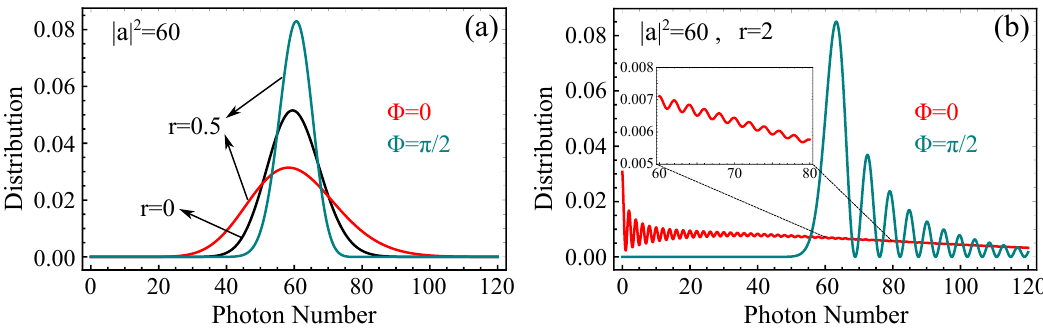
Figure 2. ( a ) Photon number distribution of a squeezed coherent state with | a | 2 = 60 and r = 0.5, compared with the respective distribution of a coherent state ( r = 0, black line). ( b ) Photon number distribution of a squeezed coherent state with | a | 2 = 60 and r = 2. In both panels, the red lines correspond to Φ = 0, while the teal lines correspond to Φ = π /2.